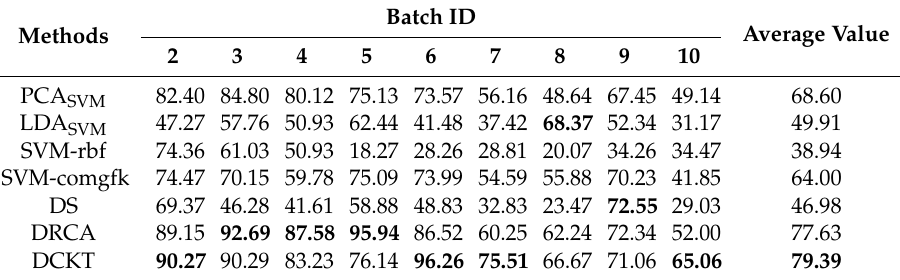
Table 2. Recognition accuracy (%) under Experimental Setting 1.